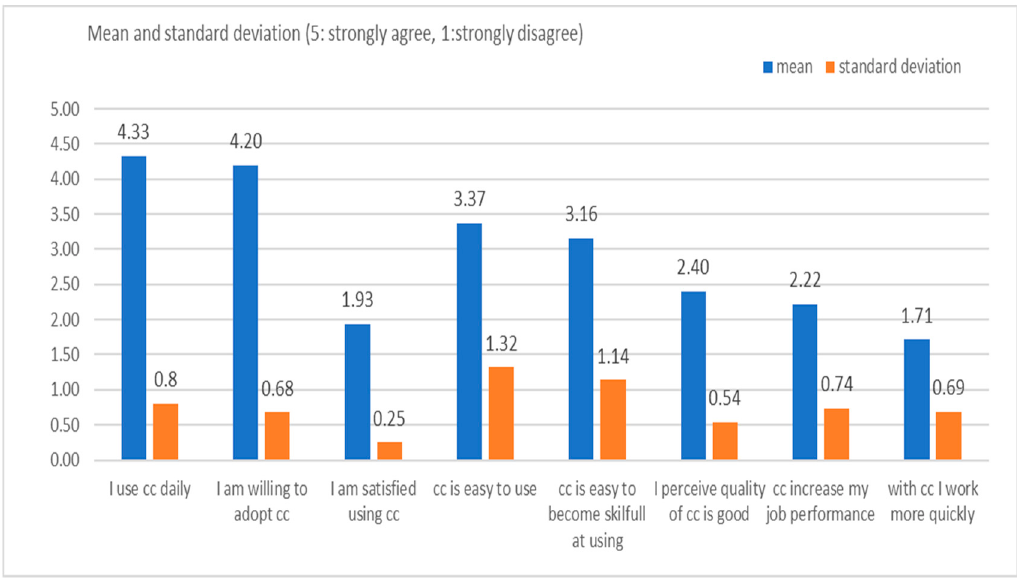
Figure 7. Cloud Computing (cc) adoption variables.